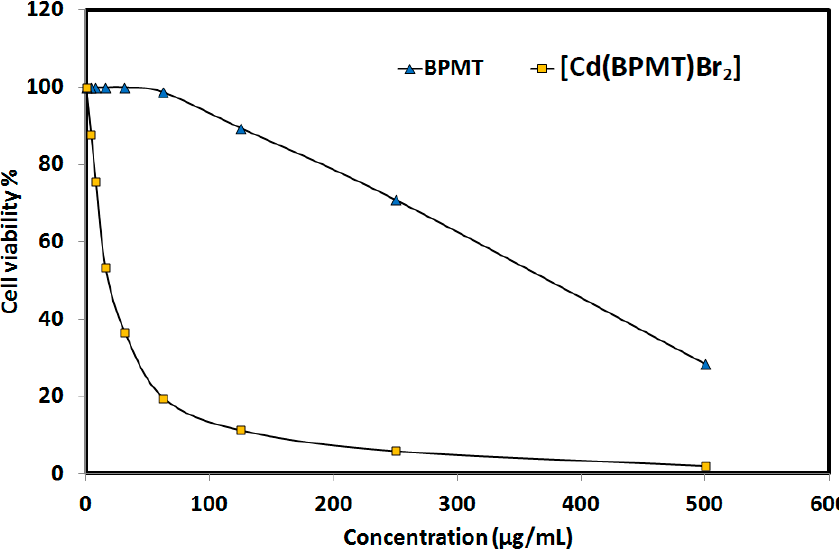
Figure 7. Cytotoxic activity of the [Cd(BPMT)Br 2 ] complex against lung cancer cells (A-549). The detailed results are tabulated in Tables S1 and S2.